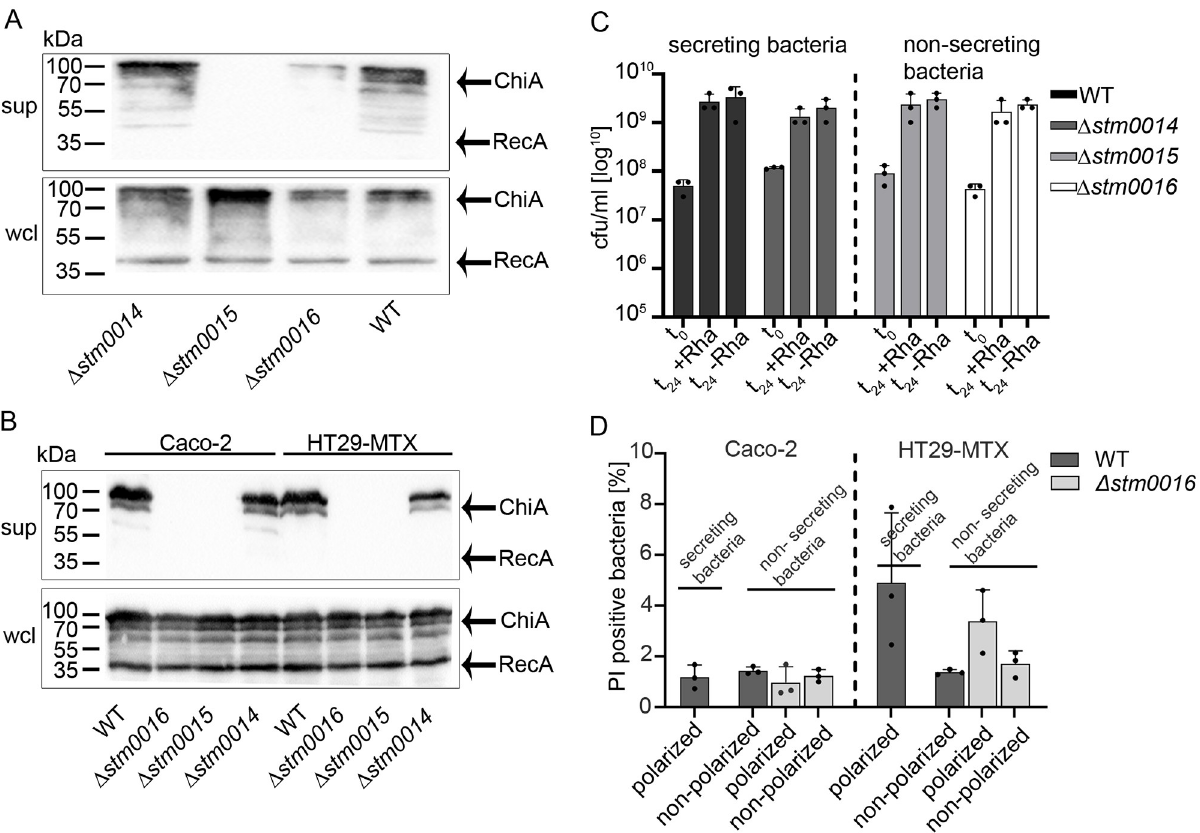
Fig 4. The secretion of ChiA depends on a holin and a peptidoglycan hydrolase. (A) The secretion of ChiA in bacterial cultures. S . Typhimurium wild-type, Δ stm0014 (putative regulator), Δ stm0015 (holin), and Δ stm0016 (peptidoglycan hydrolase) mutants, carrying chromosomally encoded 3xFLAG tagged ChiA, a rhamnose inducible plasmid pTG0035 ( chiR/ stm0017 ), and plasmid pTG0069 (RecA-3xFLAG) were used. The expression of ChiA was induced by adding 0.1% rhamnose to the chemical definded medium TTIM to overexpress chiR ( stm0017 ). The Western blot analysis shows the expression of ChiA in the whole cell lysates (wcl) and its secretion to the cell-free bacterial supernatants (sup) after 24 h growth. (B) The secretion of ChiA upon contact with polarized IEC. The same set of strains as mentioned before was used to analyse ChiA secretion upon contact for 3 h with polarized Caco-2 and HT29-MTX cells. The Western blot analysis shows the expression of ChiA in the whole bacterial cell lysates (wcl) and its secretion in the cell-free bacterial supernatants (sup). The cytoplasmic RecA protein was used as a negative control for bacterial cell lysis. (C) CFU counts of indicated bacterial strains under bacterial culture conditions permissive for ChiA secretion as shown before (A). The wild-type and indicated mutant strains were harvested and plated on LB agar plates before (t 0 ) and after 24 h growth with rhamnose (t 24 + Rha) to induce ChiA expression and secretion and without rhamnose (t 24 —Rha), a condition that does not lead to ChiA expression and secretion. The CFU counts were quantitated, to demonstrate that CFUs of strains positive for ChiA secretion (wild-type and Δ stm0014 ) were indistinguishable to strains impaired in ChiA secretion ( Δ stm0015 and Δ stm0016 ). In addition, the induction of ChiA by stm0017 overexpression (+ rhamnose) did not result in CFU differences when compared to non-ChiA-inducing conditions (- rhamnose). (D) Propidium iodide (PI) staining of bacteria in contact with polarized and non-polarized IEC. After 3 h contact with indicated IEC, bacteria were stained with PI and analyzed by flow cytometry. Displayed is the proportion (percentage) of PI- positive bacteria (dead bacteria) compared to the total pool of analyzed bacteria. Statistical analyses were implemented with ordinary one-way ANOVA and Bonferroni´s multiple comparisons test with a P value of 0.6074 (Caco-2) and 0.0741 (HT29-MTX), and a P value summary of not significant (P >